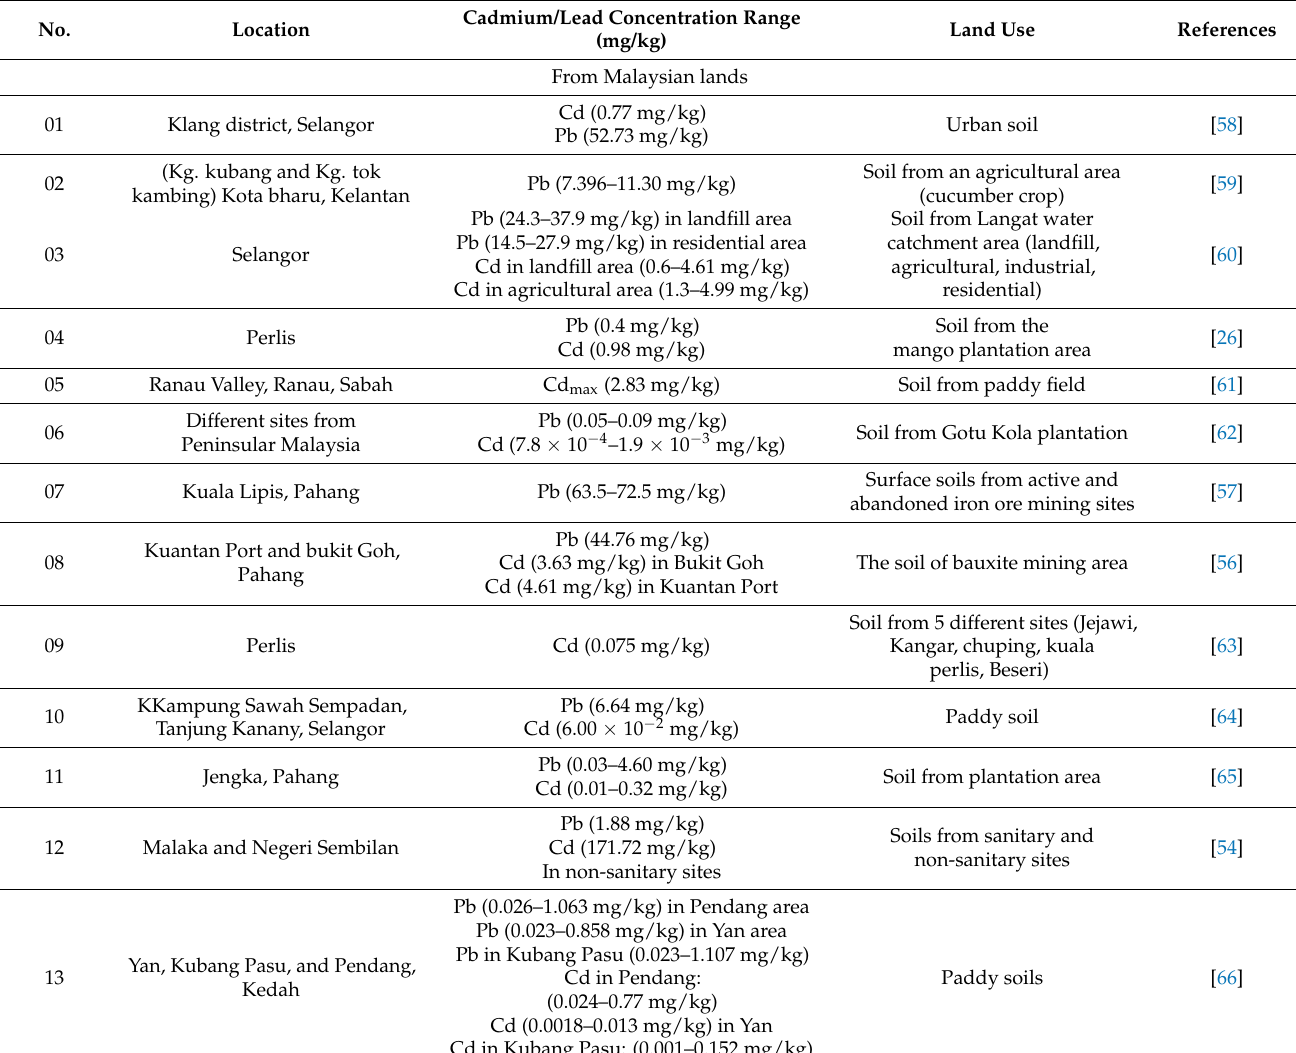
Table 3. Cadmium and lead concentration ranges in different soils from previous